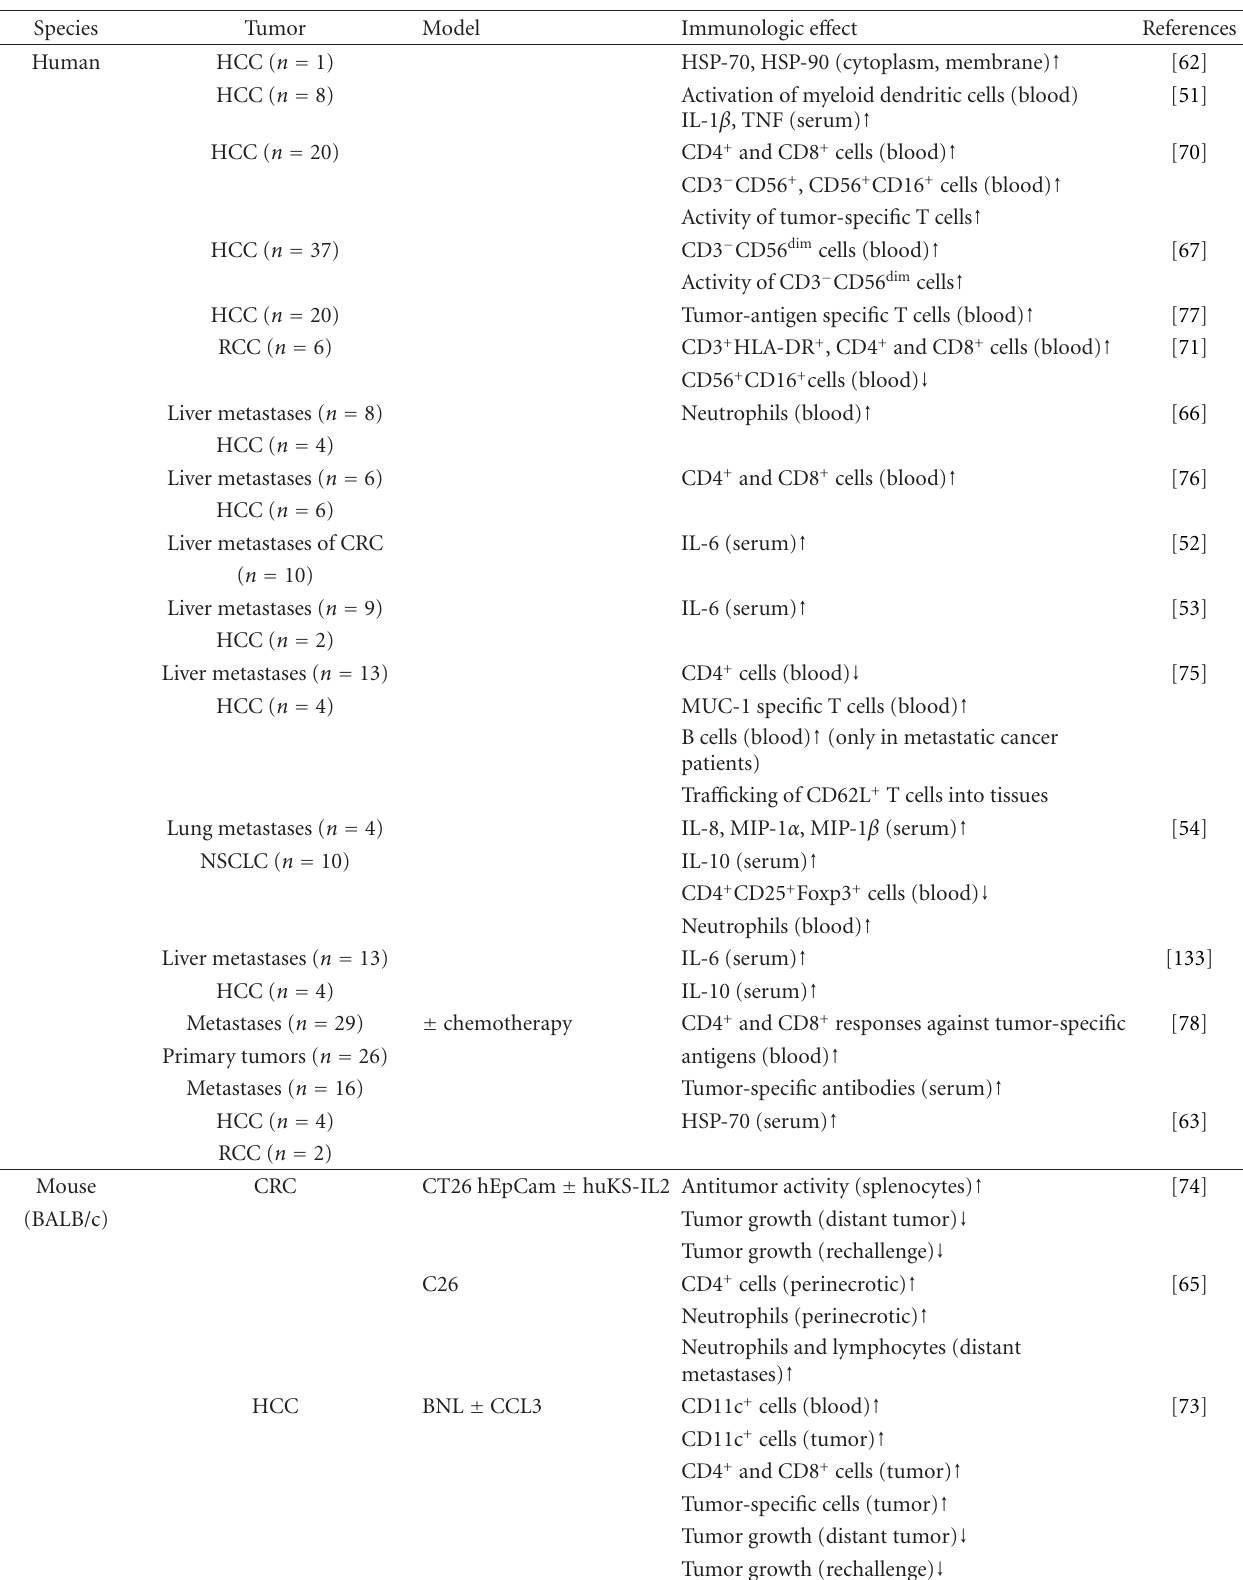
Table 2: Studies reporting immune modulation in cancer patients and animal models treated with RF